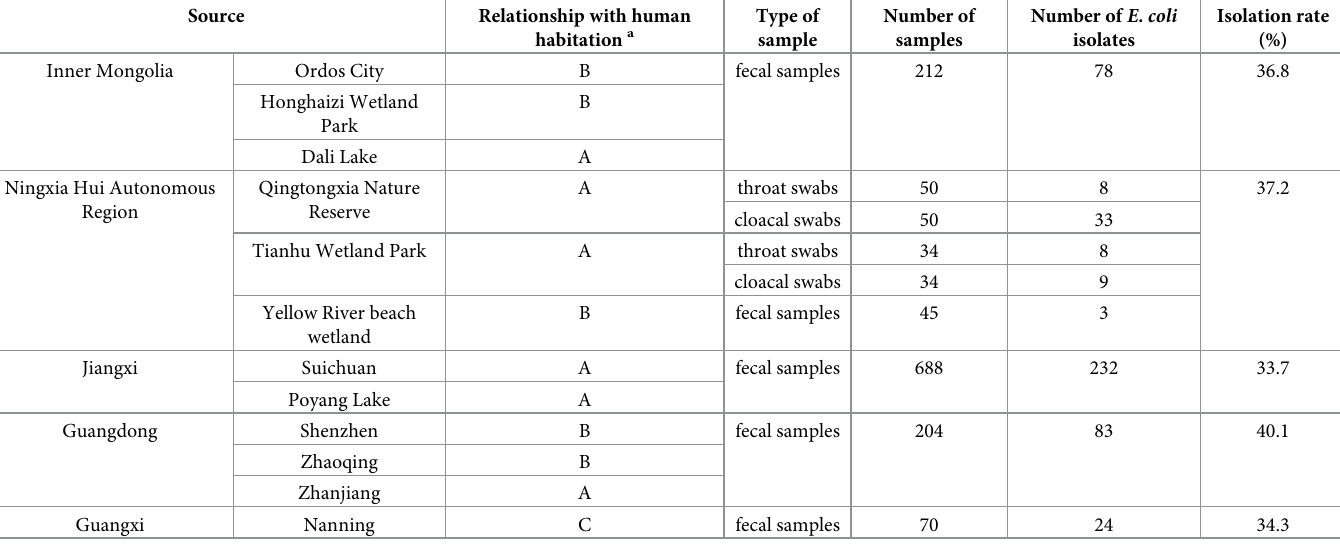
Table 2. The samples and E . coli isolates used in this study.